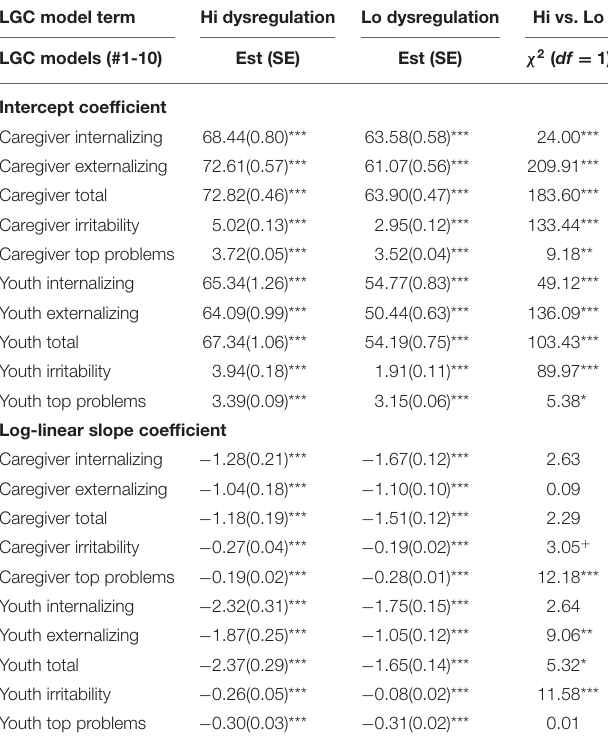
TABLE 2 | Latent intercept and log-linear slope growth terms for high and low dysregulation groups. LGC model term